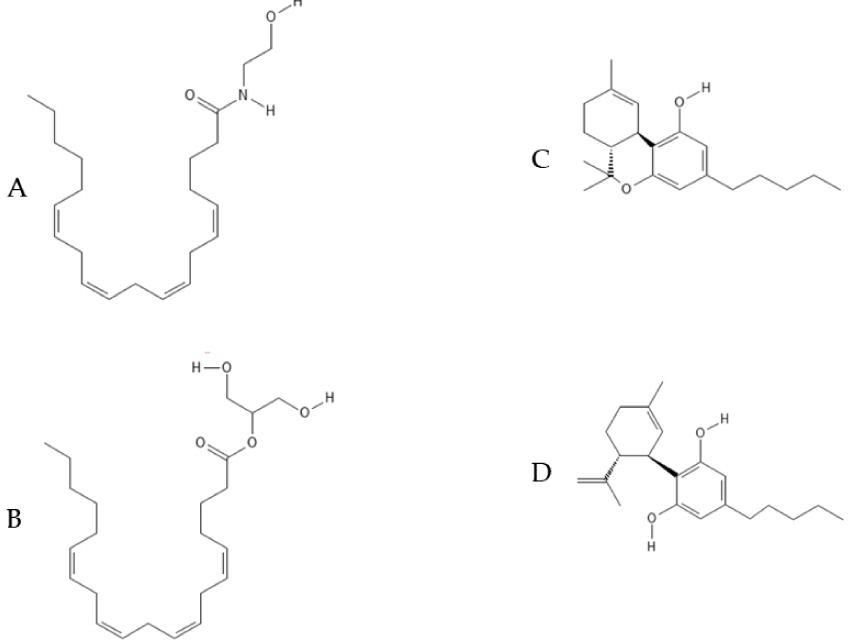
Figure 2. Chemical structure of the previously mentioned cannabinoids. ( A ) Anandamide (AEA); ( B ) 2-arachidonoyl glycerol (2-AG); ( C ) ∆ 9 -tetrahydrocannabinol (THC); ( D ) cannabidiol